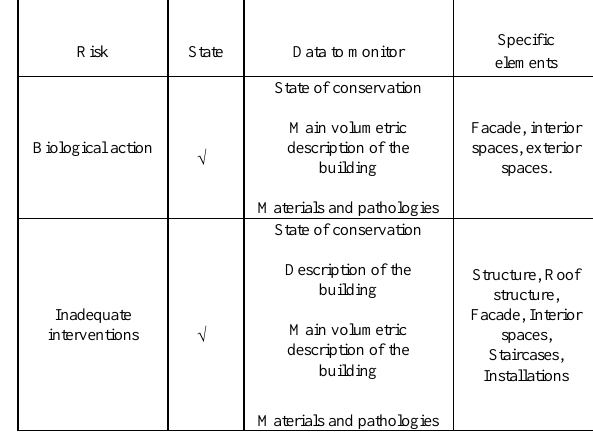
Table 3 . Items in terms of heritage